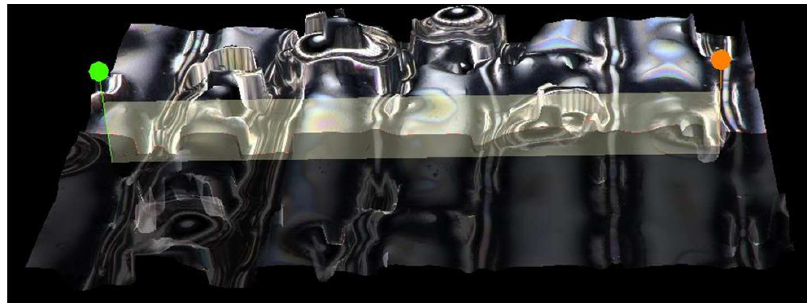
Figure 12. The surface profile of the VGS-Cu package in Figure 11a, measured by LM.